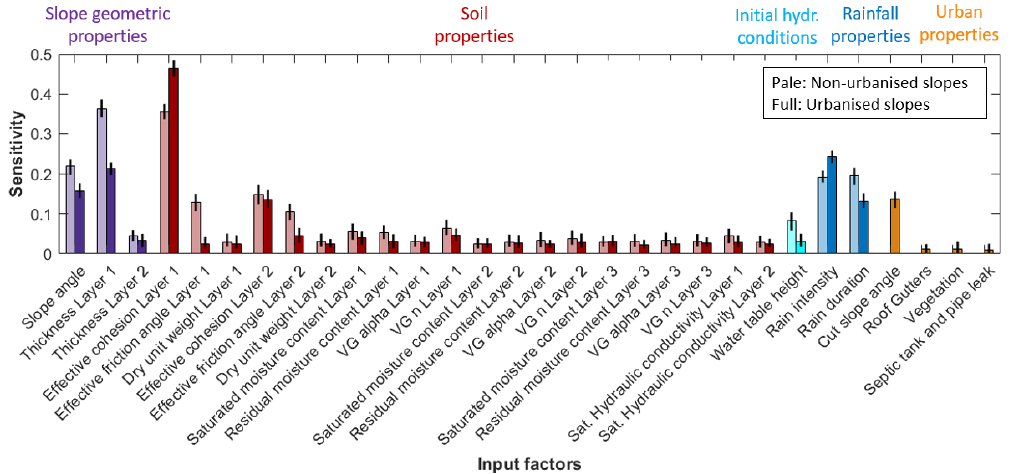
Figure 6. Sensitivity index for each input factor in the urbanised (full colour) and non-urbanised (pale colour) cases. The bars correspond to the mean value of sensitivity for each input factor calculated with bootstrapping, while the vertical black lines at the top of the bars represent the confidence interval (number of bootstrap resampling N = 100; significance level for the confidence intervals: 0.05).